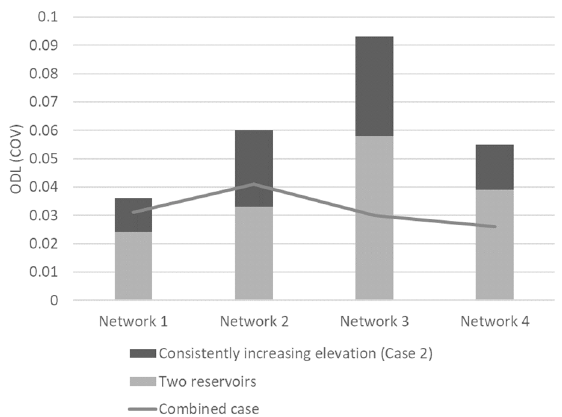
Figure 10. ODLs of the combined case with two reservoirs and consistently increasing elevation compared to individual cases.